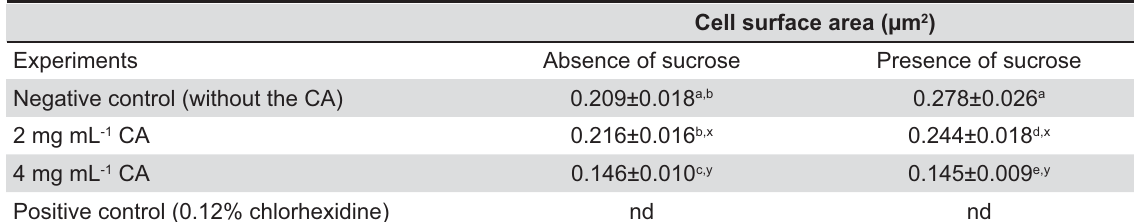
Table 2- Comparison of the changes in the size of S. mutans ATCC 25175 cells when grown in different concentrations of the crude aqueous Piper betle L. extract (CA), in the absence and presence of sucrose (1%). (Statistical analysis; two-way ANOVA; scanning electron microscope at 10,000x)